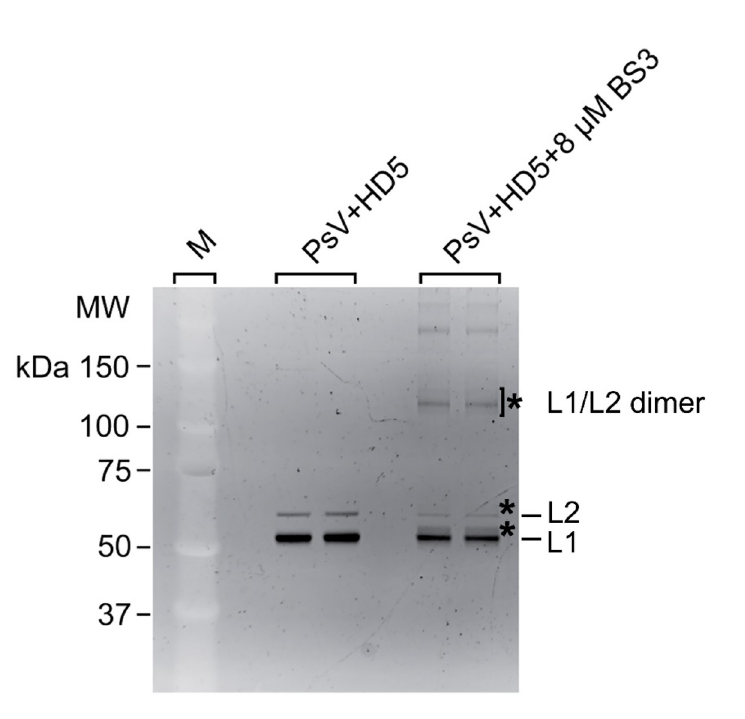
Supplementary Figure 2. SDS PAGE used in BS3 crosslinking mass spectrometry study. Sample lanes with HPV16 pseudovirus (PsV) plus HD5 both with and without 8 μM BS3 are indicated along with a molecular weight marker lane (M). A mutant HD5 containing substitutions of two arginine residues (R13 and R32) for lysine (HD5-R13K/R32K) was used for this study to provide two additional primary